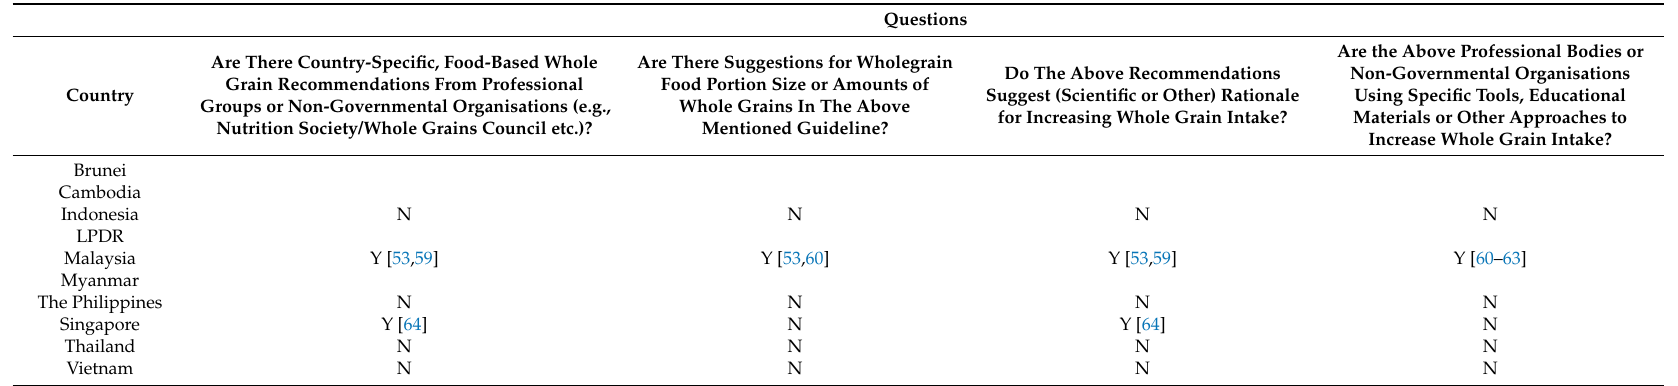
Table 3. Whole grain-related recommendations from professional bodies/non-governmental organisations in the ASEAN member states. LPDR = Lao People’s Democratic